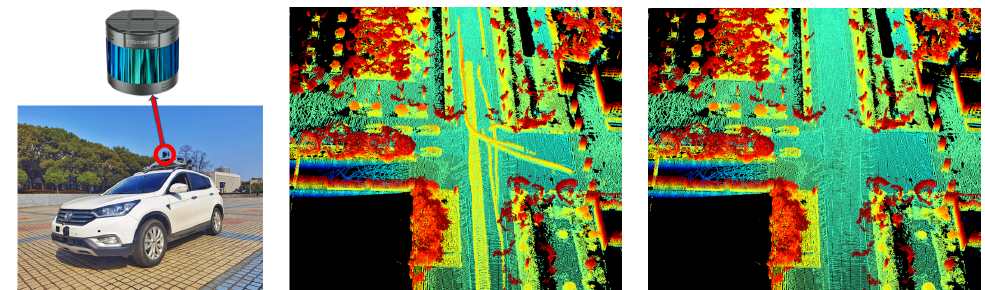
Figure 18. The left figure shows our own experimental platform equipped with a Robosense Ruby 128-channel LiDAR. The middle figure shows the original map, and the right figure shows the map cleaning results by the proposed method. Points are colored based on the height